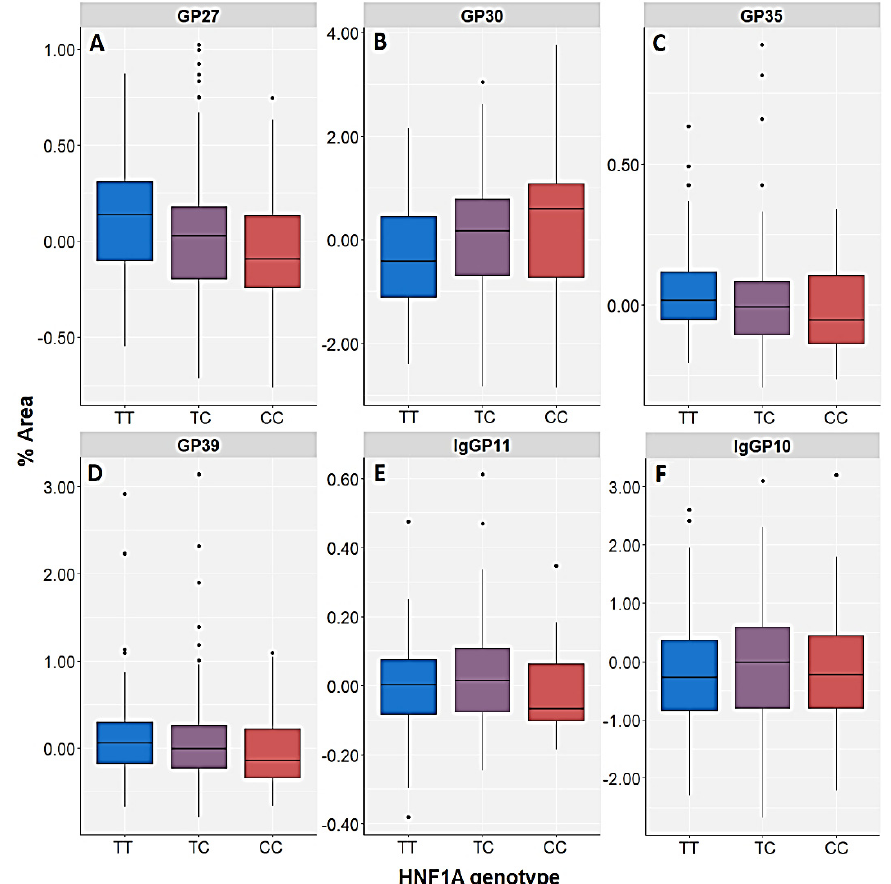
Figure 5. Relative distribution of the plasma N-glycan peaks (GP27 (A3G3S3) ( A ), GP30 (A3G3S3) ( B ), GP35 (A4F1G3S3) ( C ) and GP39 (A4F1G4S4) ( D )), as well as the IgG N-glycan peak IgGP11 (FA2[3]BG1) ( E ) in patients with PTSD and the IgG N-glycan peak IgGP10 (FA2[6]BG1) ( F ) in the control subjects, both subdivided according to different genotypes of the HNF1A rs735396 polymorphism. The central box represents the interquartile range of the age-adjusted percentage of the total N-glycan peak area, the middle line represents the median, the vertical line extends from the minimum to the maximum value and separate dots represent outliers.